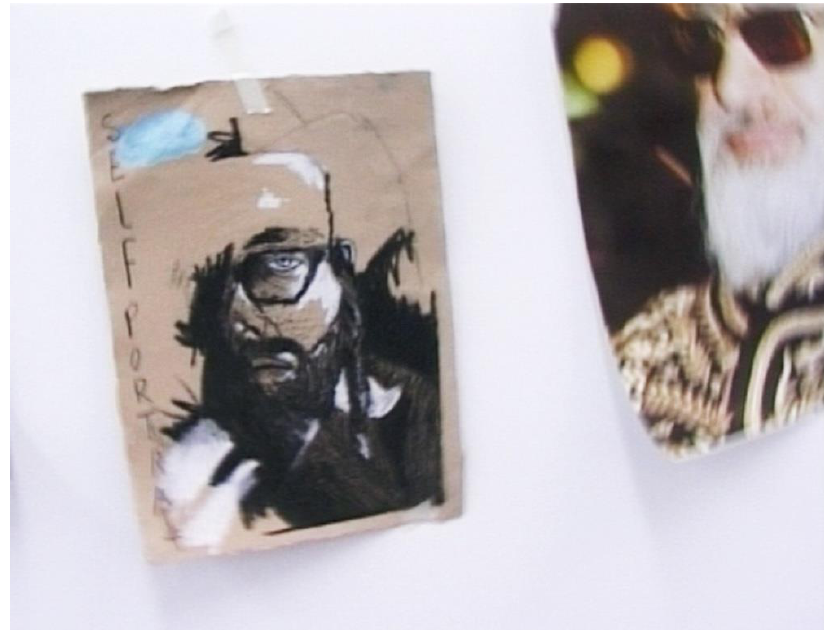
Figure 16. Oreet Ashery, What Is Like for You? , 2000, 04:06. Video still, 00:57 min. Courtesy of the artist.